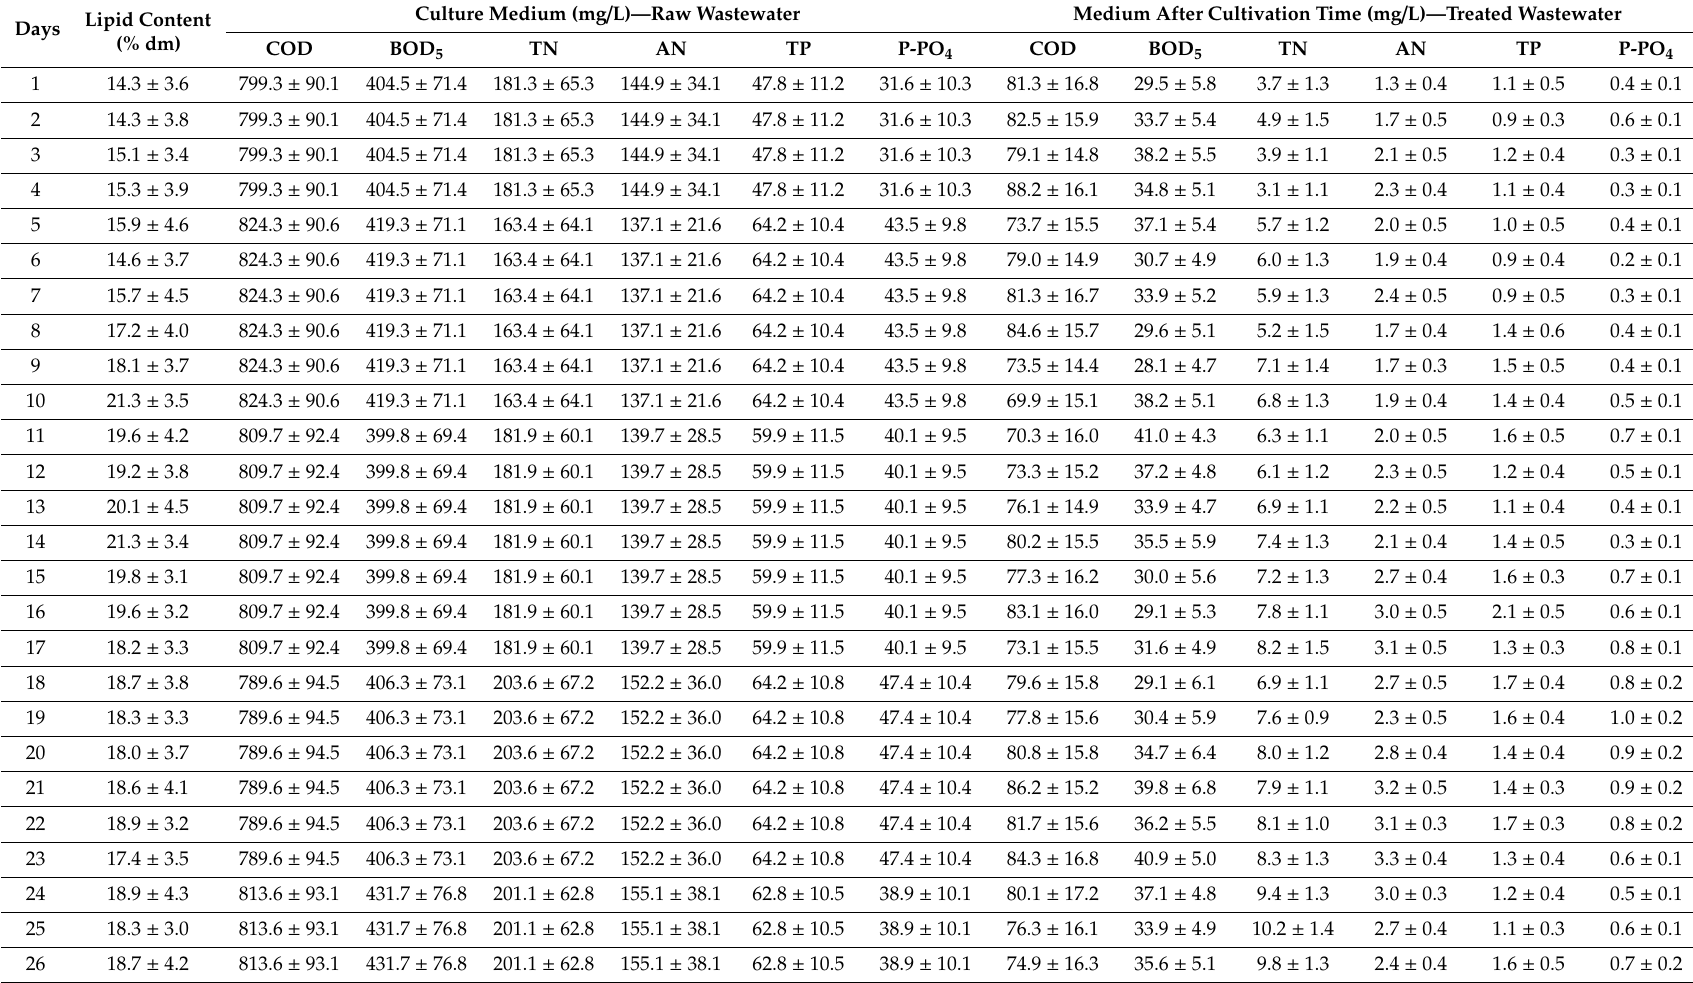
Table 2. Lipid content of the microalgae biomass, and characteristics of the culture medium (raw sewage) and the medium after the cultivation time (treated wastewater) in Stage